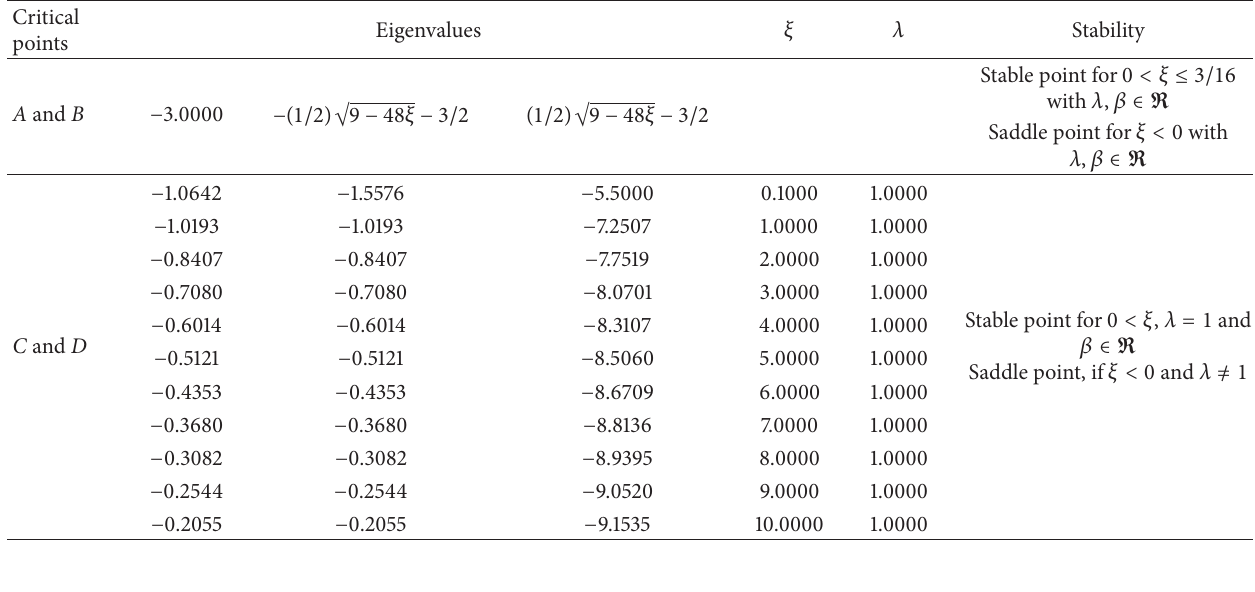
Table 2: Eigenvalues and stability of critical points.